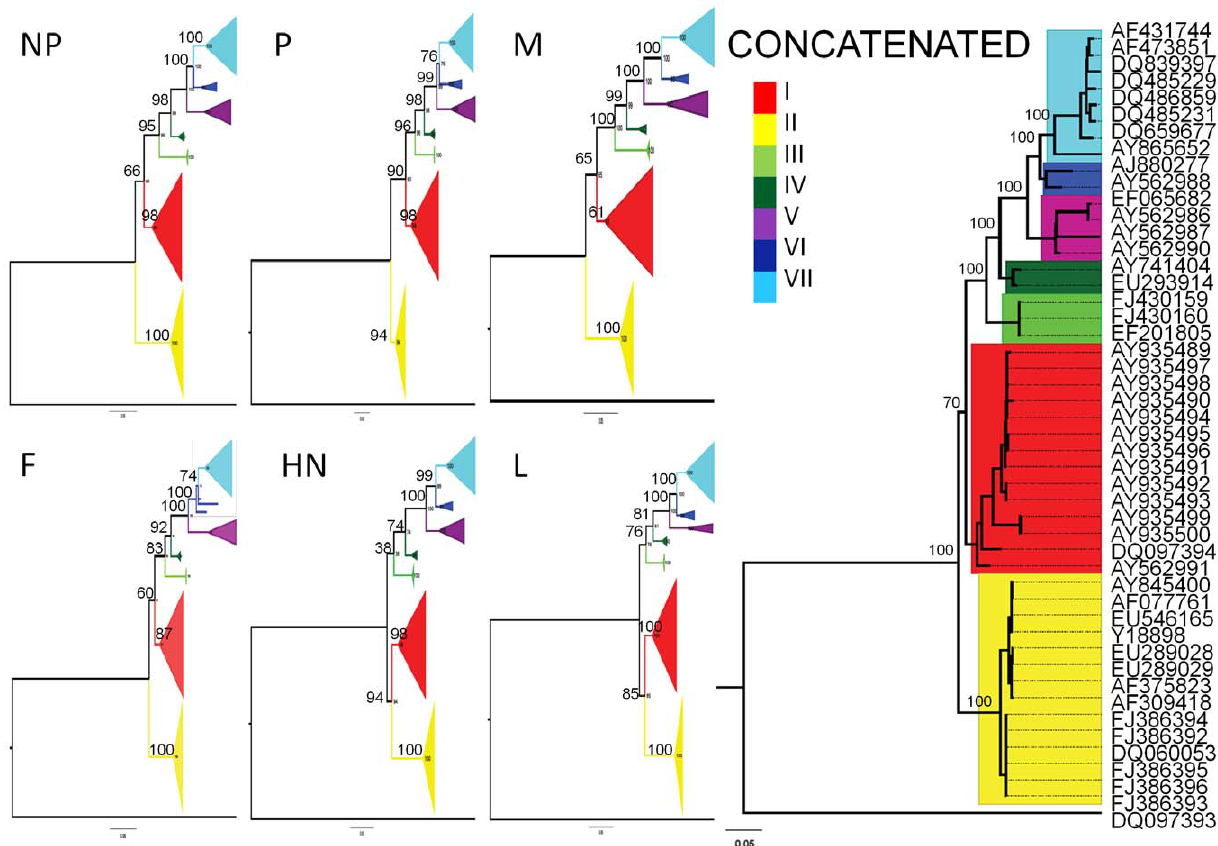
Figure 4. Phylogenetic relationships among 48 non-recombinant isolates. A maximum likelihood tree was produced after removal of the six putative recombinant sequences. The color scheme, rooting, and bootstrap values are as described in Figure 1.